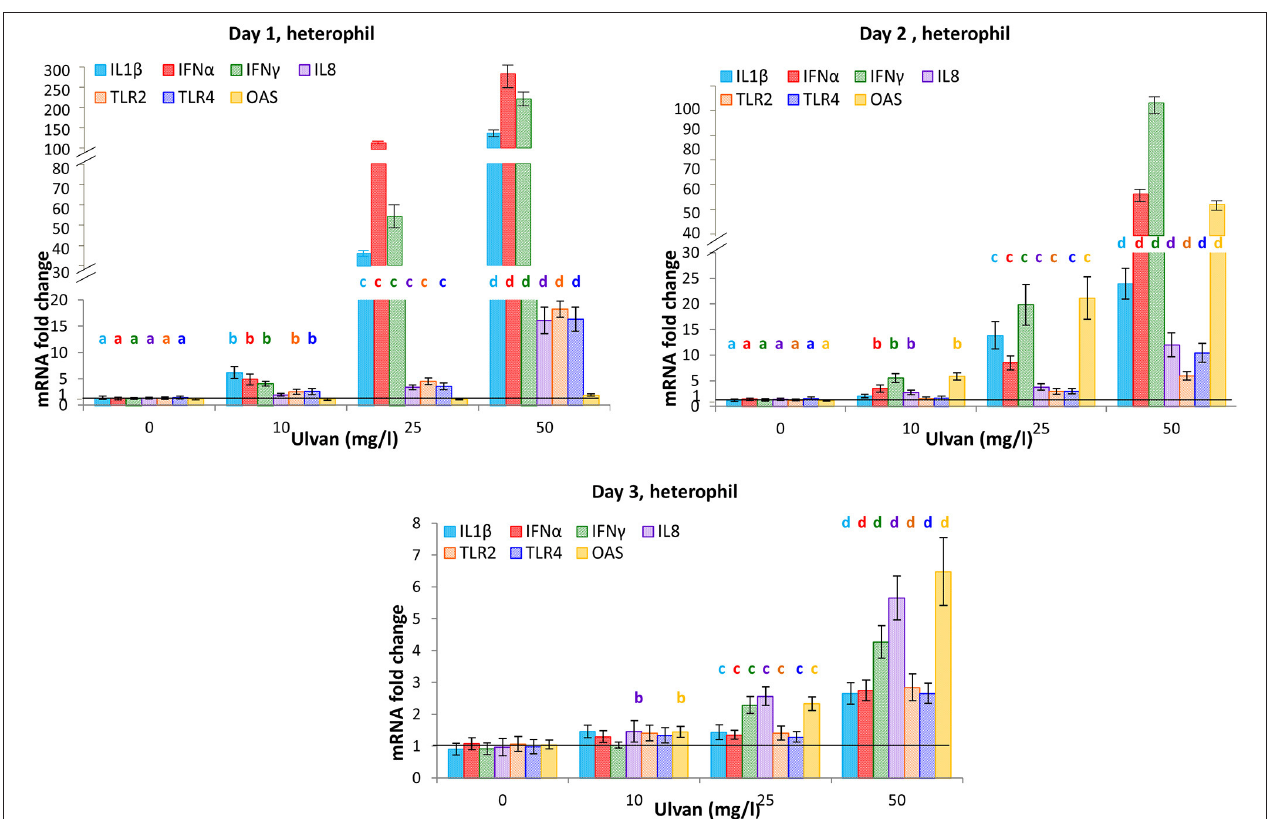
FIGURE 5 | Heterophils respond to ulvan by modifying the transcription pattern of cytokine genes. Ulvan was given per os at four different concentrations (0, 10, 25, 50 mg/l) to the animals at day 0. Blood samples (1ml per animal) were taken every day from day 0 to day 3. Cellular pellets of three animals were pooled to obtain sufficient number of cells for purification and RT-qPCR. Data represents the mean ± SEM of three independent experiments with 25 chickens per group. Different letters with the same color indicate statistically different values for the different doses at the same time with p <